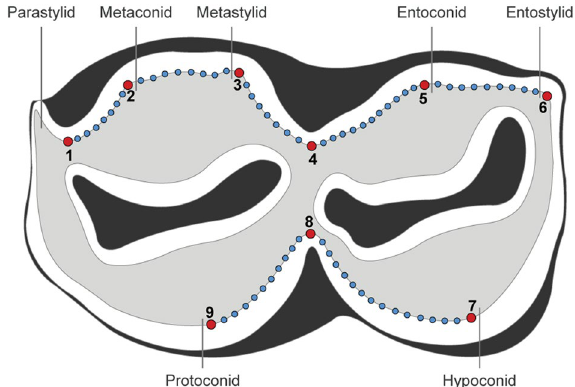
Figure 6. Landmarks and semilandmarks locations on the left lower molar (m1 and m2) of reindeer in occlusal view. 1 : point of maximum curvature between the parastylid and the metaconid; 2 : point of maximum curvature on the metaconid; 3 : point of maximum curvature on the metastylid; 4 : point of maximum curvature between the metastylid and the entoconid; 5 : point of maximum curvature on the entoconid; 6 : point of maximum curvature on the entostylid; 7 : point of maximum curvature on the hypoconid; 8 : point of maximum curvature between the hypoconid and the protoconid; 9 : point of maximum curvature on the